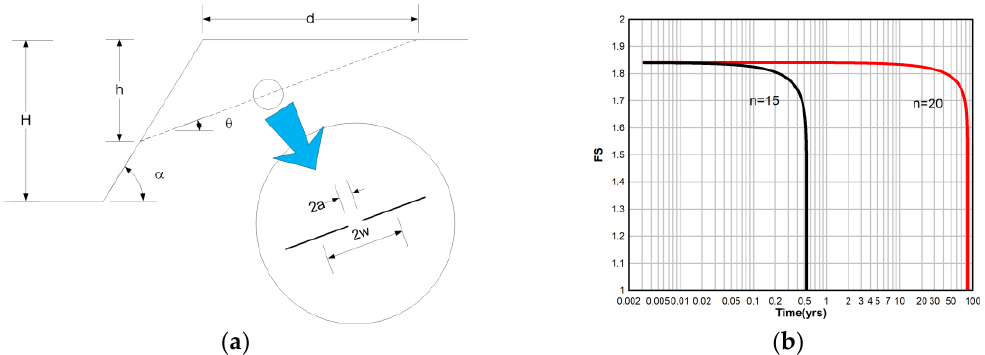
Figure 18. Example of time-dependent slope stability model: ( a ) slope model geometry; ( b ) factor of safety as a function of time.